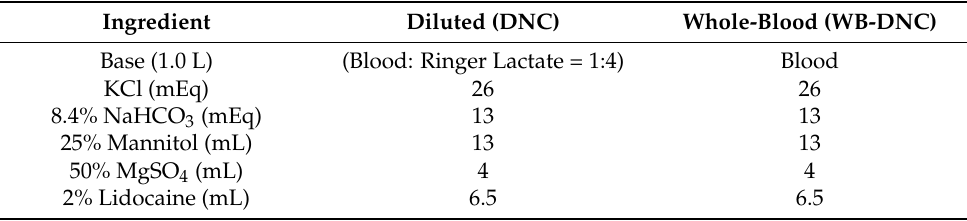
Table 1. Drugs delivered in 1.0 L of Del Nido-based cardioplegia